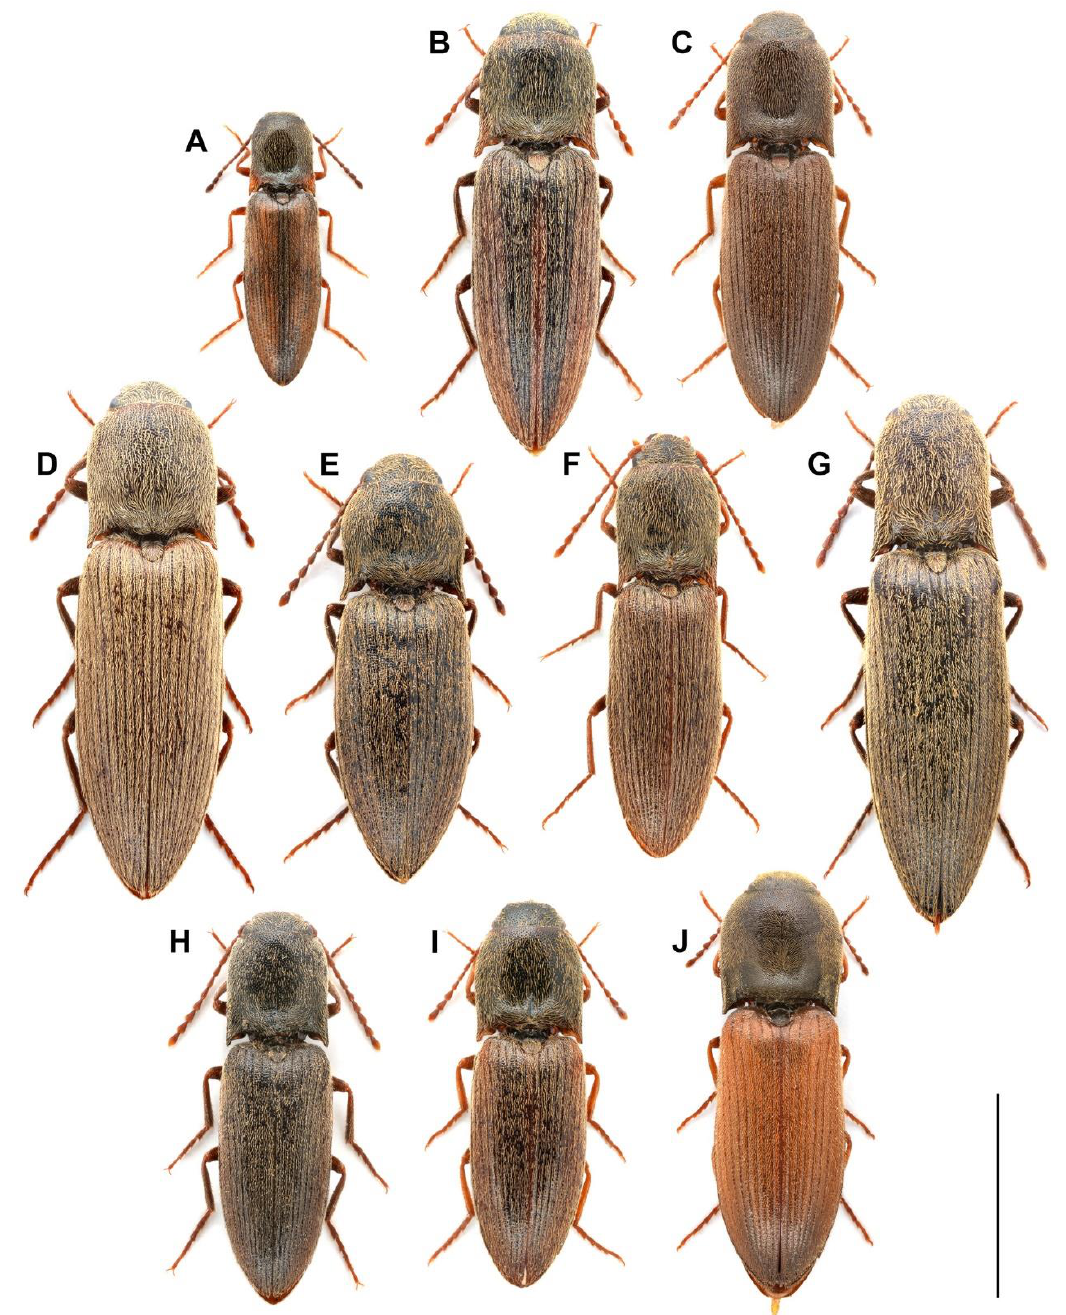
Figure 1. Habitus images of the examined Agriotes species. ( A ) A. acuminatus ; ( B ) A. lineatus ; ( C ) A. medvedevi ; ( D ) A. modestus ; ( E ) A. obscurus ; ( F ) A. paludum ; ( G ) A. pilosellus ; ( H ) A. rufipalpis ; ( I ) A. sputator ; ( J ) A. ustulatus . Scale bar = 5 mm. Table 1. List of Agriotes material used for the SEM study. M, male; F, female. Code Species Sex Geographic Origin